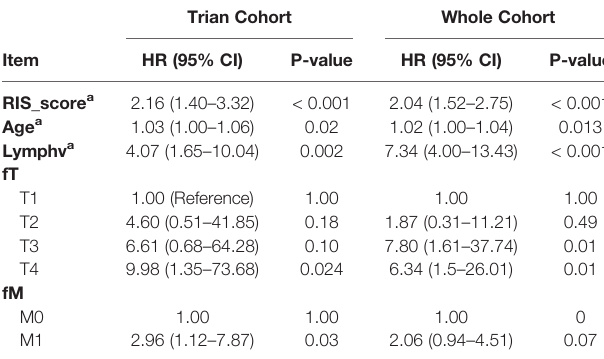
TABLE 4 | Multivariable Cox regression analysis of clinical pathological parameters in training cohort and the whole cohort. Trian Cohort Whole